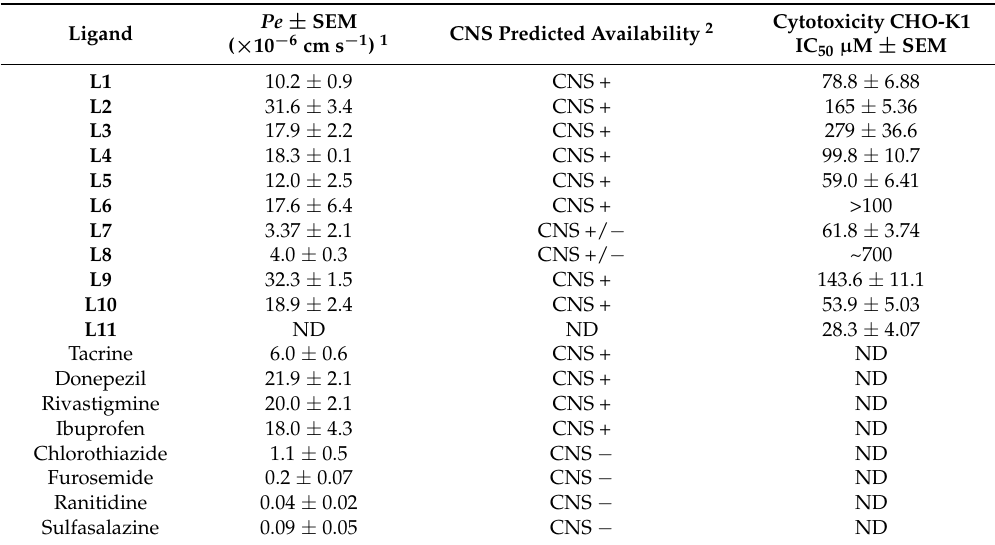
Prediction of the blood-brain barrier penetration and cytotoxicity data of studied compounds, L1 – L11